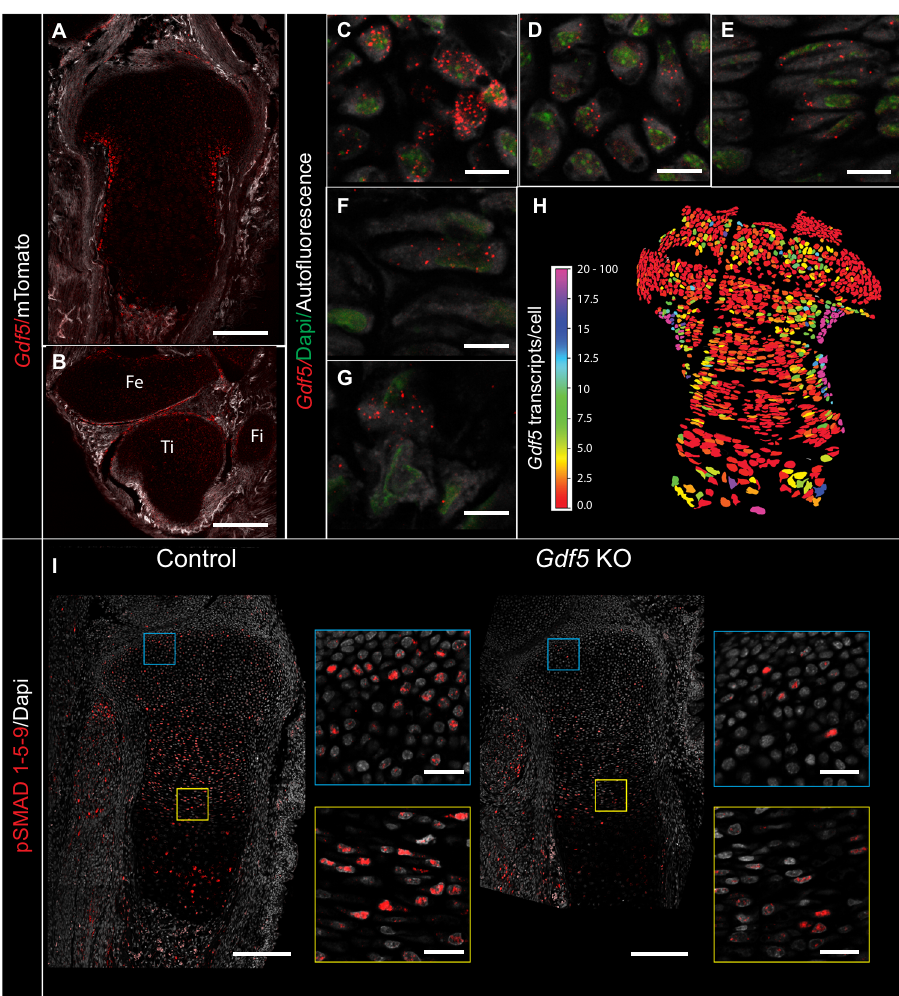
Fig. 5 GDF5 is expressed in the growth plate and regulates SMAD 1/5/9 activity. A , B HCR smFISH for Gdf5 in the proximal tibia ( A ) and knee joint (Fe, femur; Ti, tibia; Fi, fi bula) ( B ). Scale bars: 200 µ m. C – G Gdf5 is expressed in the collar region ( C ), resting zone ( D ), proliferative zone ( E ), prehypertrophic zone ( F ), and hypertrophic zone ( G ) ( n = 4 biologically independent samples examined over 3 independent experiments). Scale bars: 10 µ m. H A heat map shows the number of Gdf5 transcripts per cell throughout the proximal tibia growth plate ( n = 3). The highest signal per cell is in the collar region, followed by the proliferative zone adjacent to the collar, and some areas in the resting zone. Many cells in the center have between 0 and 2 transcripts. I Immuno fl uorescence for pSMAD 1/5/9 shows a reduction in the proximal tibia of Gdf5 KO mice compared to controls ( n = 4 biologically independent samples examined over three independent experiments). Scale bar: 200 µ m. Blue and yellow square insets show zoomed-in regions in the resting and proliferative zones, respectively. Scale bar: 25 µ